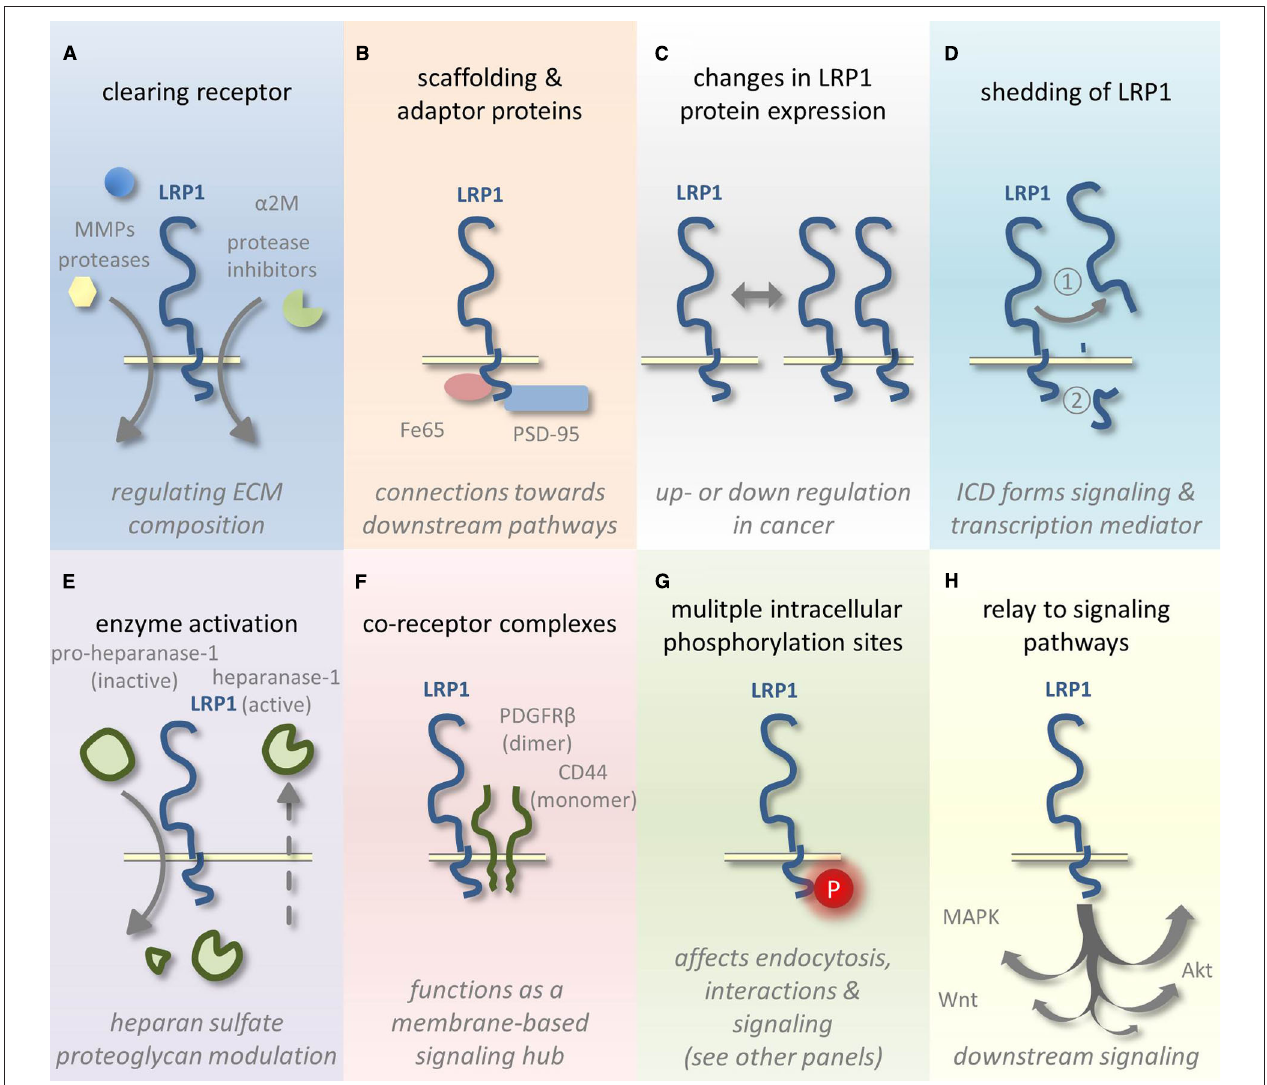
FIGURE 1 | Schematic representation of LRP1-mediated tumor growth and metastasis fine tuning. (A) LRP1 clears various cancer-related ligands from the ECM by endocytosis. (B) The LRP1 ICD also interacts with several adaptor and scaffolding proteins. (C) LRP1 expression levels vary among different tumor types and tumor stages and (D) the receptor can undergo shedding and subsequent release of the ICD. (E) Heparanase-1 activation is affected by LRP1-mediated uptake of its inactive precursor. (F) The formation of co-receptor complexes with LRP1 influences signaling and (G) also the phosphorylation of the LRP1 ICD influences signaling and regulates endocytosis. (H) LRP1-mediated signaling affects several well-known pathways linked to